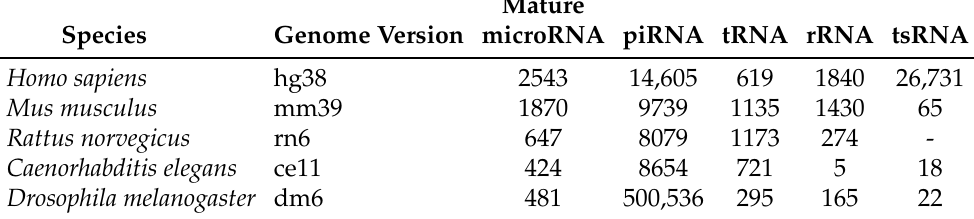
Table 5. Statistics for unique transcript IDs for ITAS, after filtration and correction. Intersections between sRNA types were not